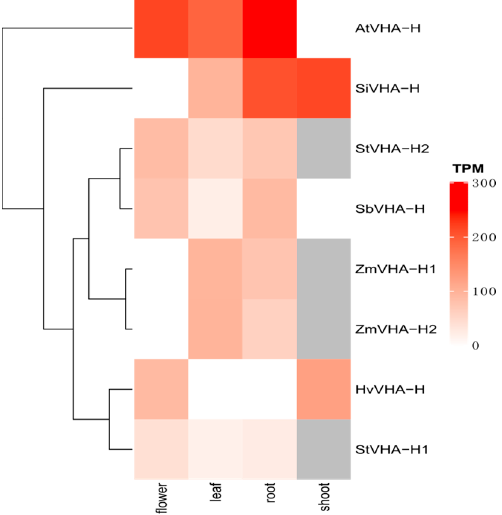
Figure 5. The expression patterns of VHA-H genes in different tissues. The heat level of each box represents the amount of expression, while the gray boxes indicate missing expression data. The clustering tree is on the left. TPM stands for transcripts per million.